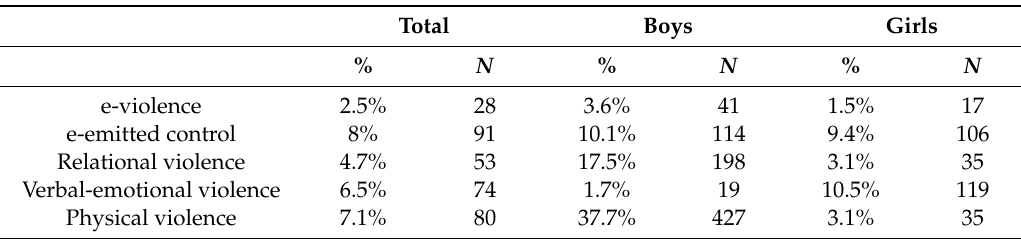
Table 1. Violence prevalence among the sample ( N = 1132).